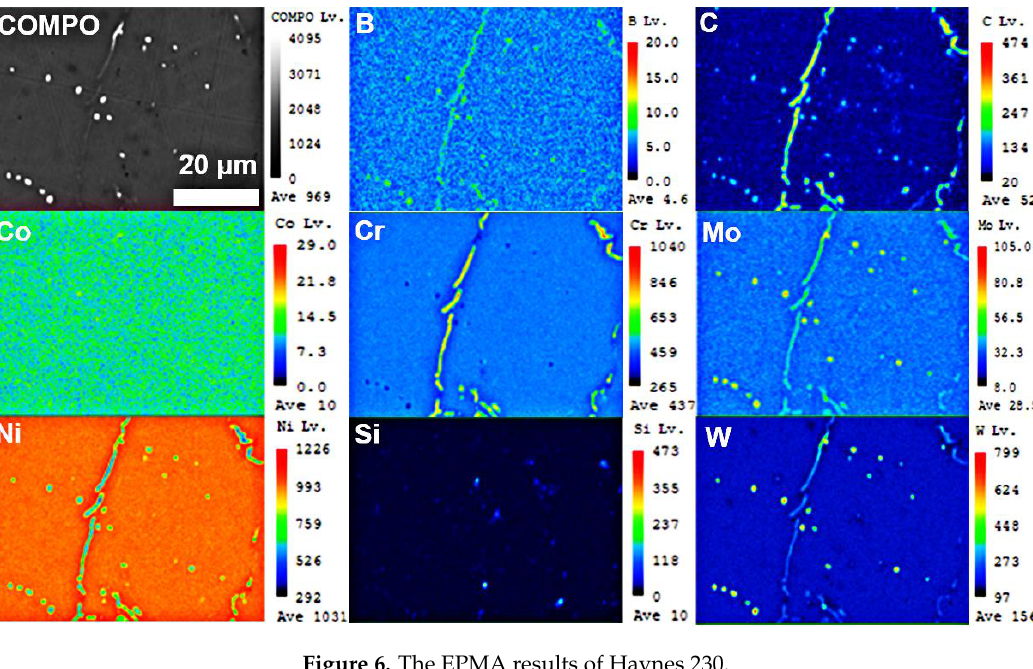
Figure 6. The EPMA results of Haynes 230.